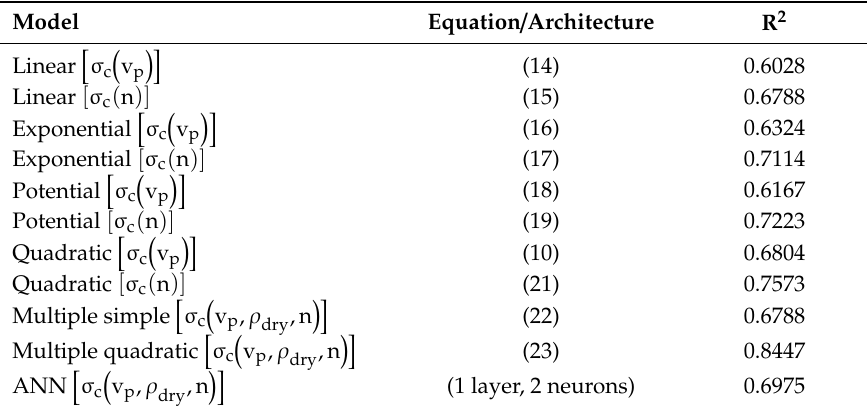
Table 7. Coe ffi cients of determination of the generated